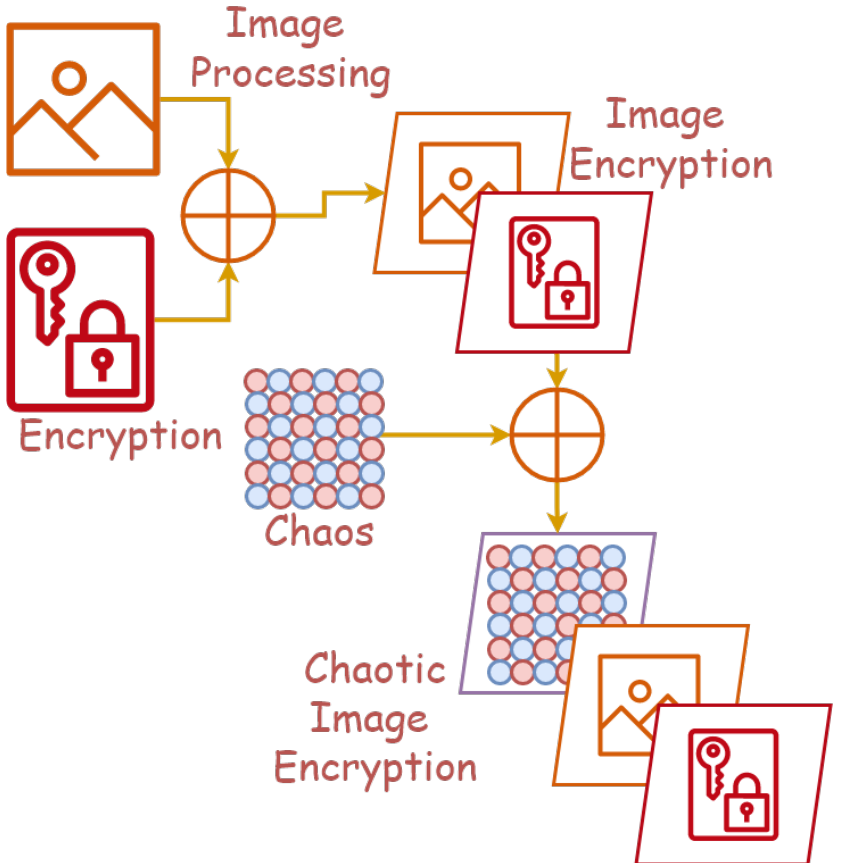
Figure 1. Chaotic Image Encryption: The Convergence Point of Image Encryption and Chaos